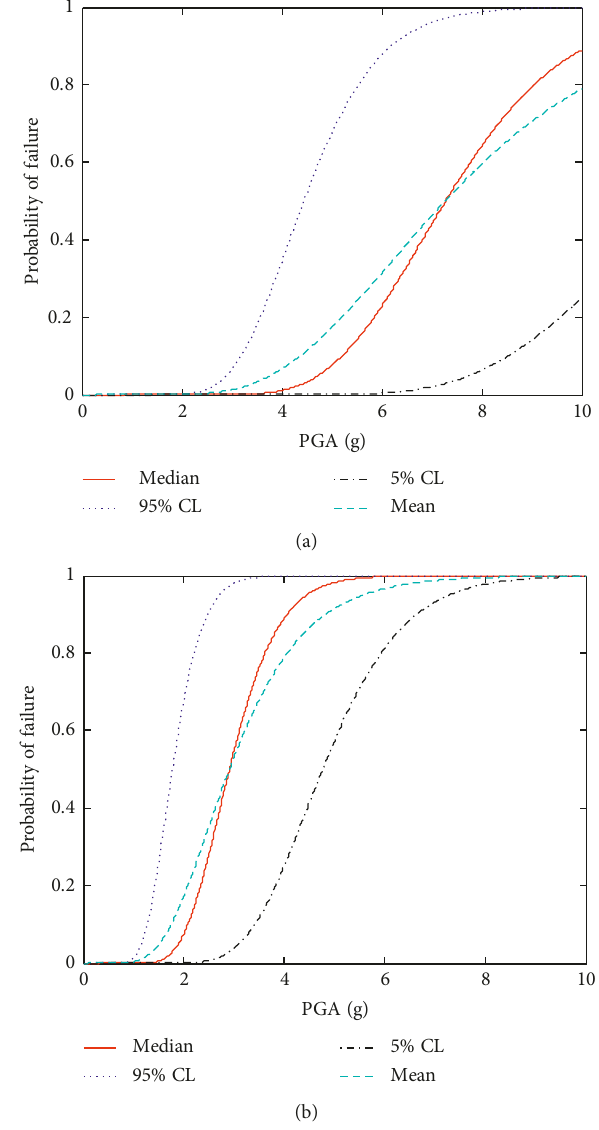
Figure 10: Seismic fragility curves: 5% confidence level, median, 95% confidence level, and mean (case 1). (a) Soft soil. (b) Hard